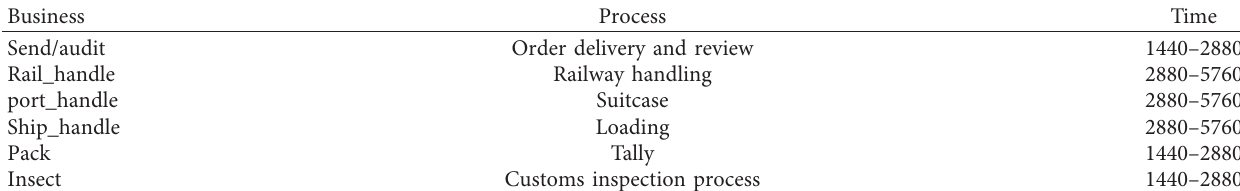
Table 6: Time consumption (min) of main business links of the process before reconstruction.